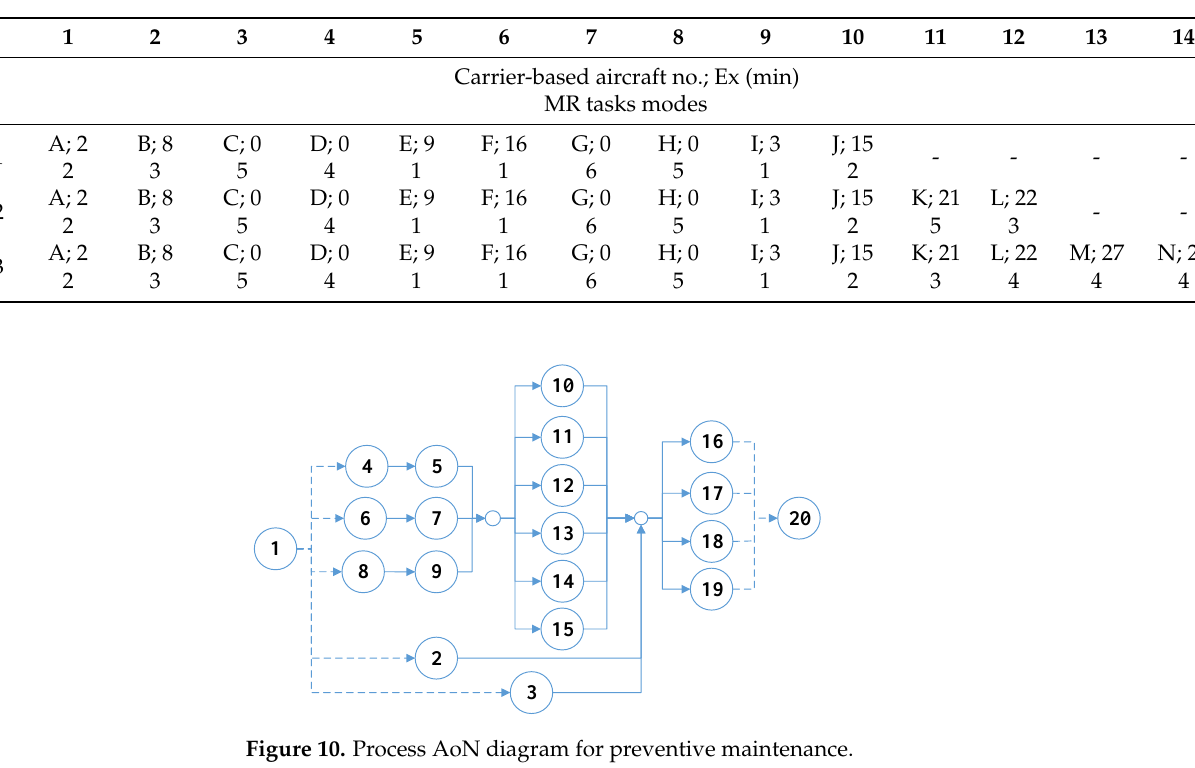
Table 2. MR tasks for fleet.